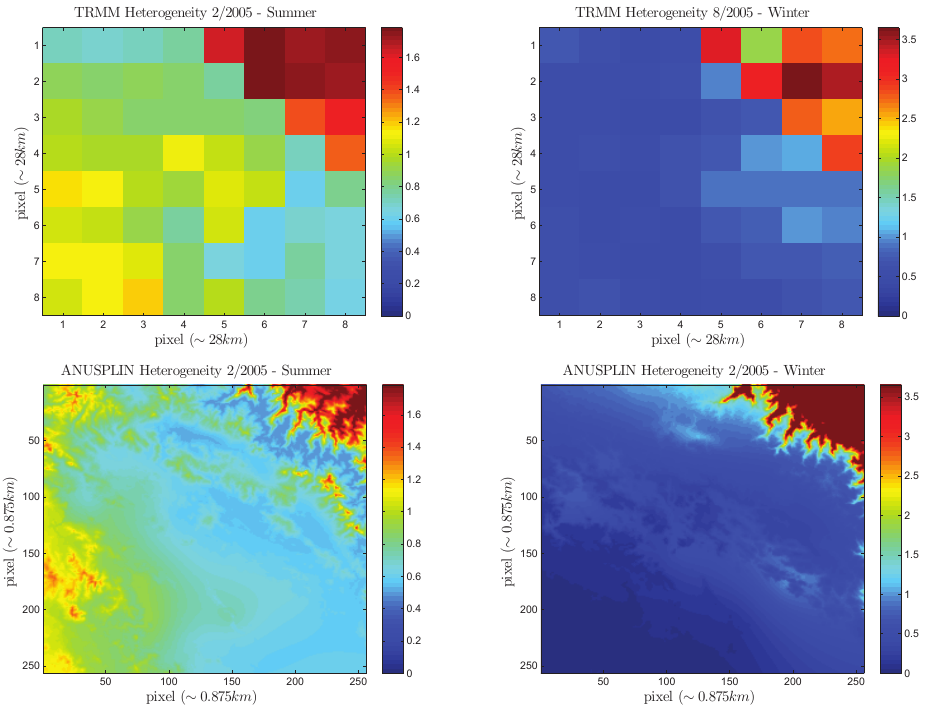
Figure 4. Illustration of summer and winter heterogeneity information from TRMM and ANUSPLIN outcomes.